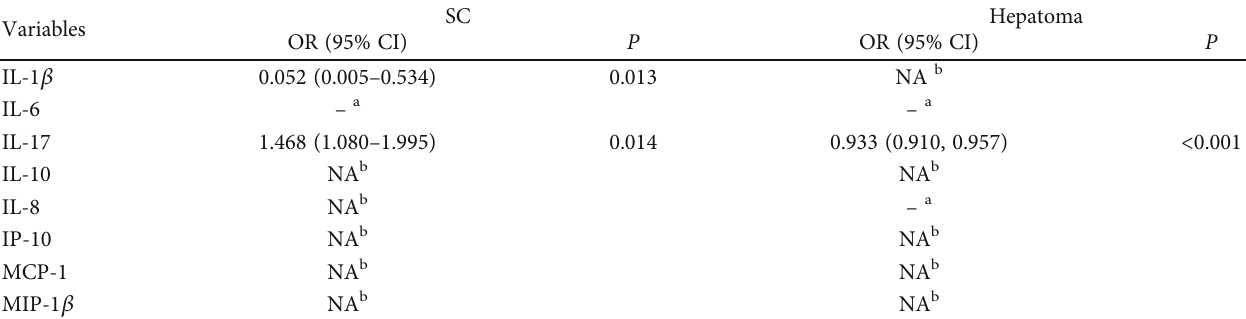
NA b NA b NA b NA b Note: a Variable was not included in the multivariate analysis because of the lack of statistical signi fi cance in the univariate analysis. b Variable was not included in the logistic regression equation based on the forward LR stepwise method. Abbreviations: CI: Con fi dence interval; IL: Interleukin; MCP-1: Monocyte chemoattractant protein-1; MIP-1 β : Macrophage in fl ammatory protein-1 β ; OR: Odds ratio; SC: Spontaneous